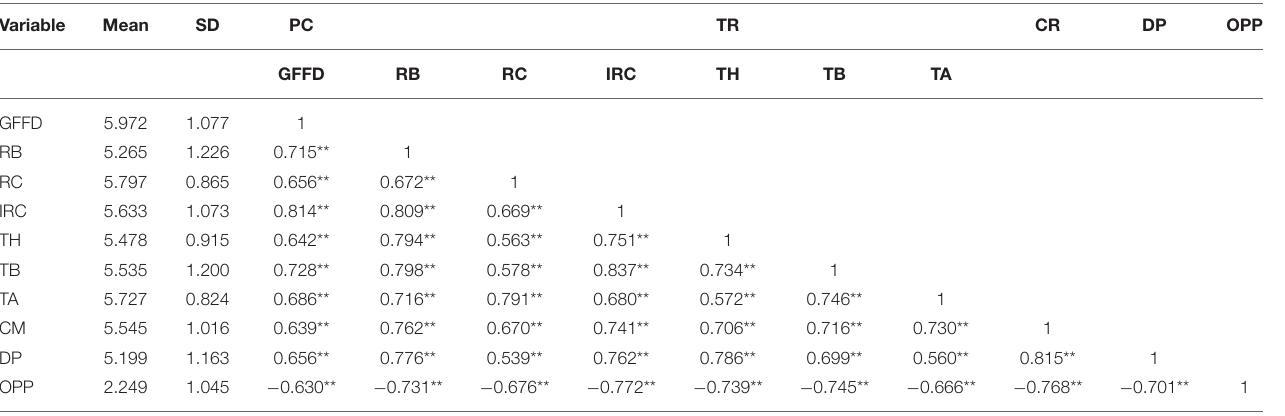
TABLE 1 | Correlation analysis results.